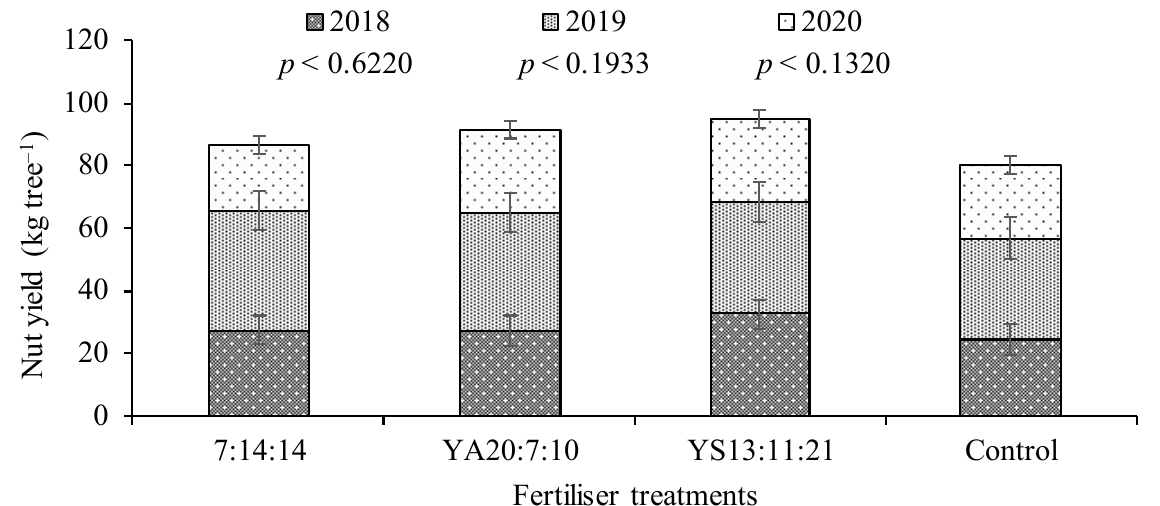
Figure 2. Average annual nut yield as a response to fertilisation treatments. Error bars are the standard errors.